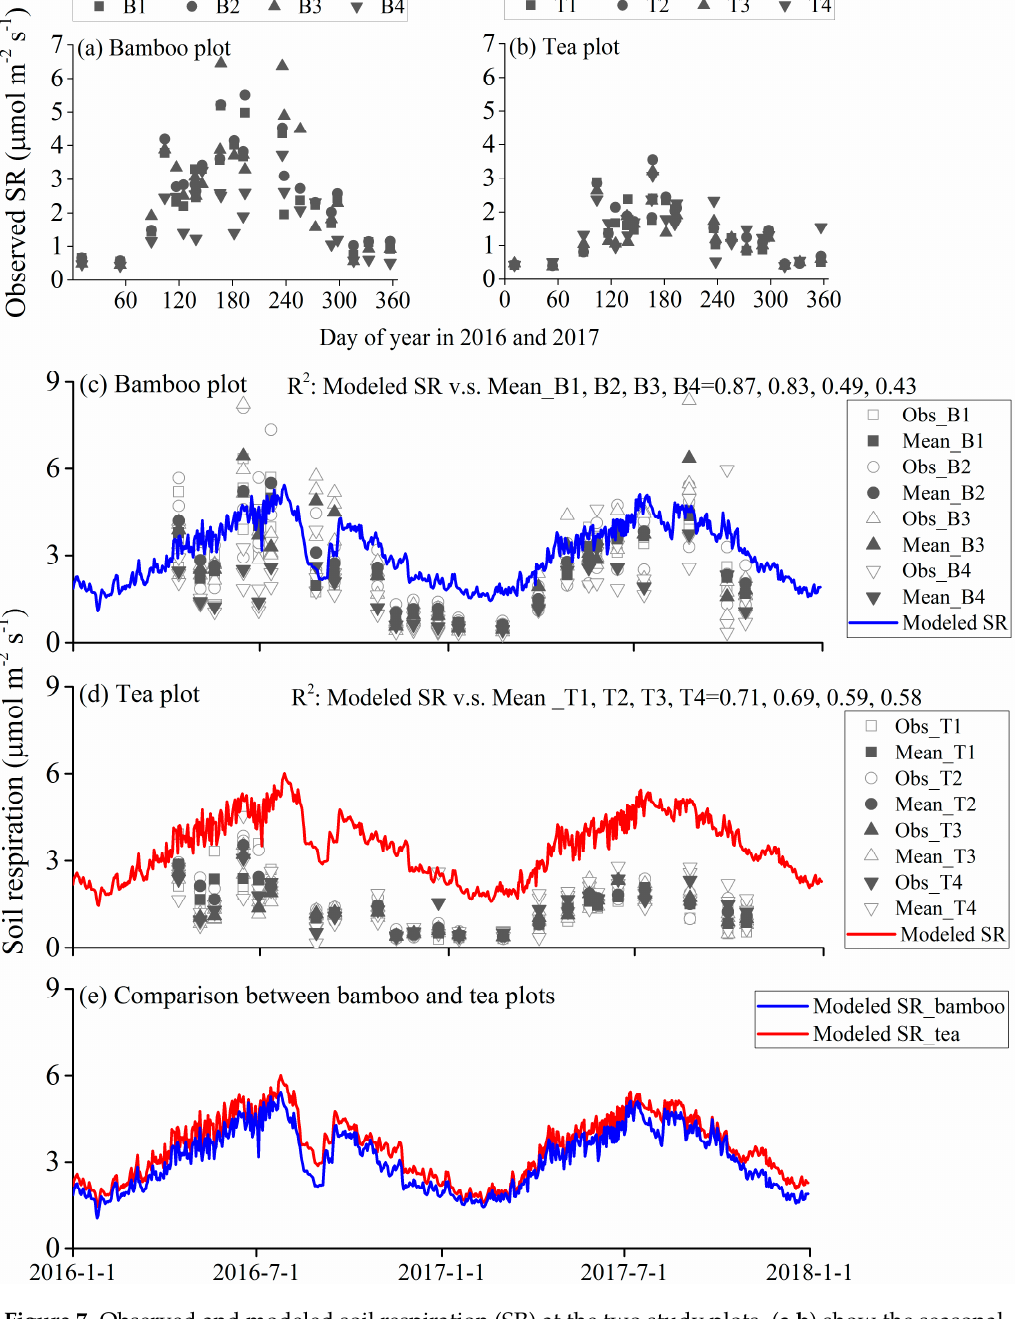
Figure 7. Observed and modeled soil respiration (SR) at the two study plots. ( a , b ) show the seasonal dynamics of the observed SR at the bamboo and tea plots, respectively; ( c – e ) show the time series of the observed and modeled SR.